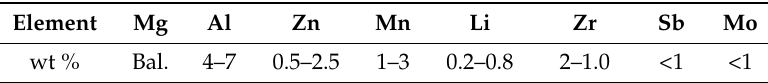
Table 1. Chemical composition of KBM10 magnesium alloy.